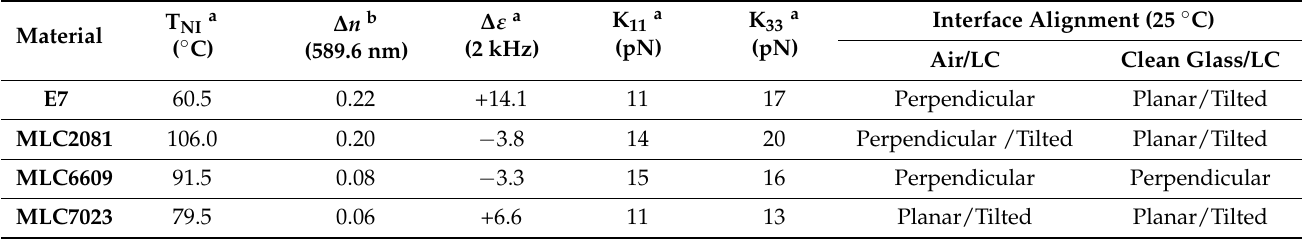
Table 1. LC mixtures and their relevant physical and alignment